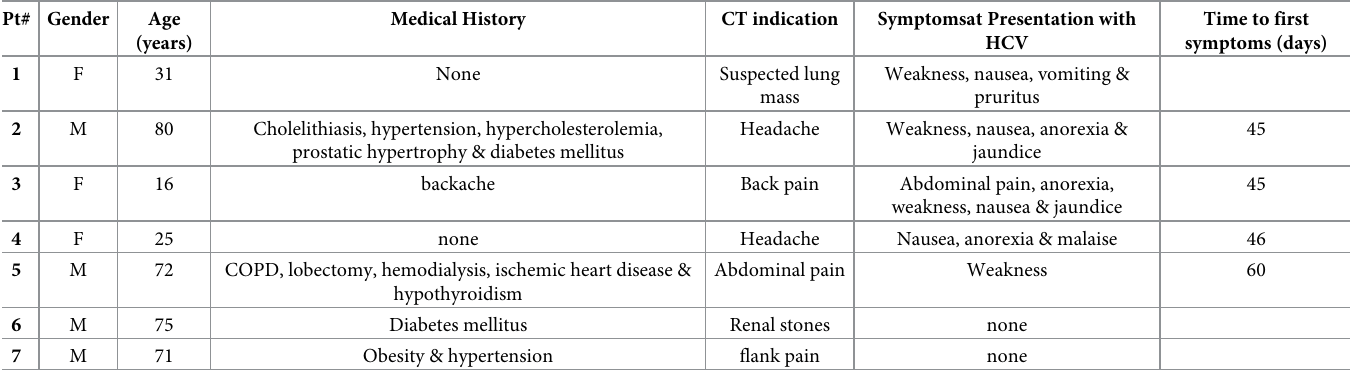
Table 1. Demographics, clinical features, and reason for CT scan.